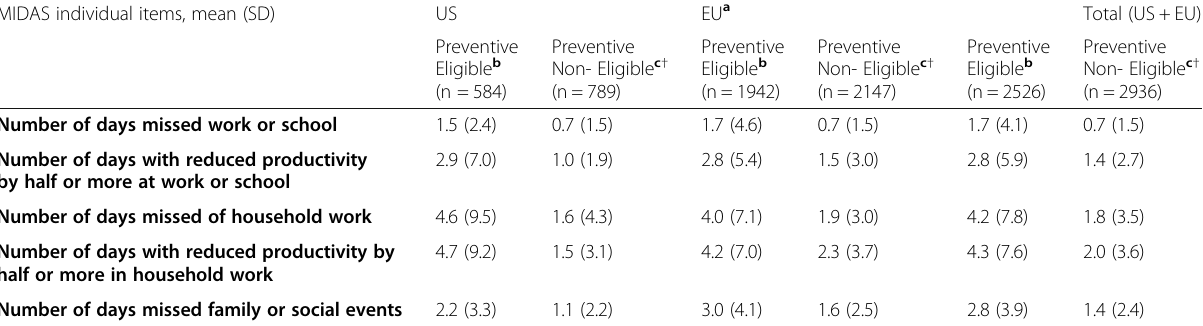
Table 2 Patient reported migraine disability individual item scores (mean [SD]) by preventive treatment eligibility status MIDAS individual items, mean